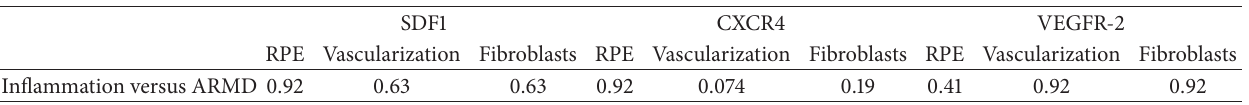
Table 1: 𝑃 values of Mann-Whitney test performed on the dataset from Guerin et al. [14] comparing the staining grading for the three molecules studied (SDF1, CXCR4, and VEGFR-2) of the three structures of a CNV.